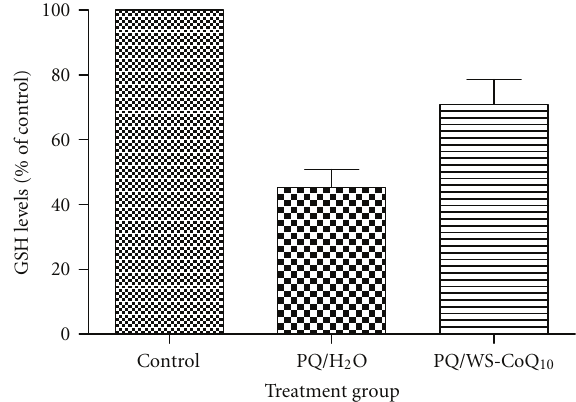
Figure 3: GSH assay. Measuring oxidative stress levels in brain tis- sue from rats challenged with paraquat and treated with WS-CoQ 10